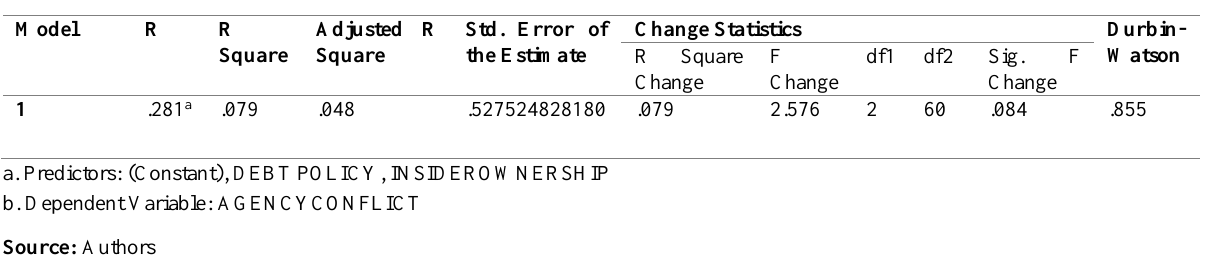
Table 10: Hypothesis 4 Testing